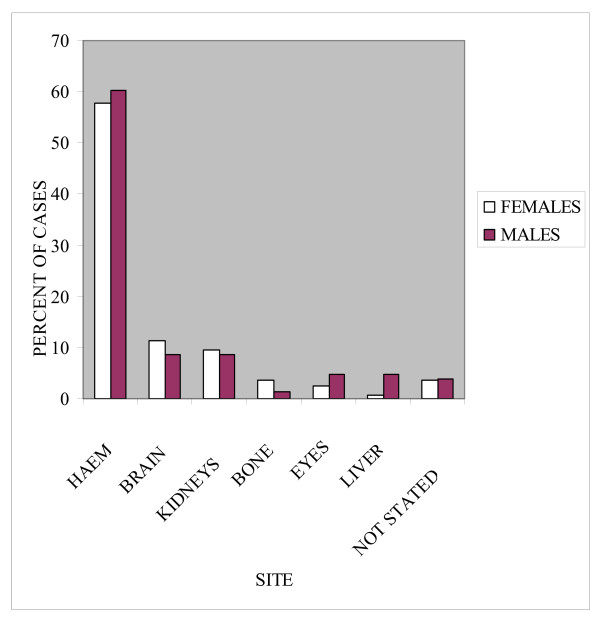
Gender distribution of cases in children.